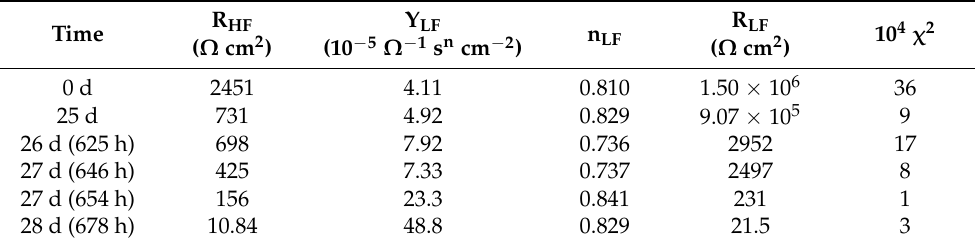
Figure 10. EIS response (Bode diagrams and Nyquist plots) of the Fe wire at 10 mm in different stages of the acid attack. Table 3. Parameters obtained from the impedance spectra of Fe wire at 10 mm depth (Figure 10).